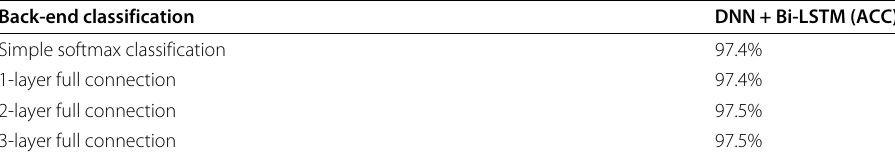
Table 5 Comparison experiment based on back-end